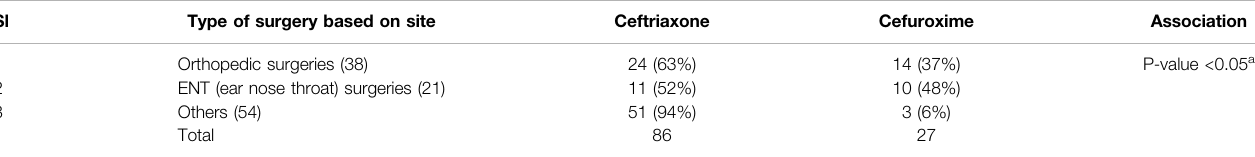
TABLE 6 | Pre-surgical use of ceftriaxone and cefuroxime based on the type of surgery